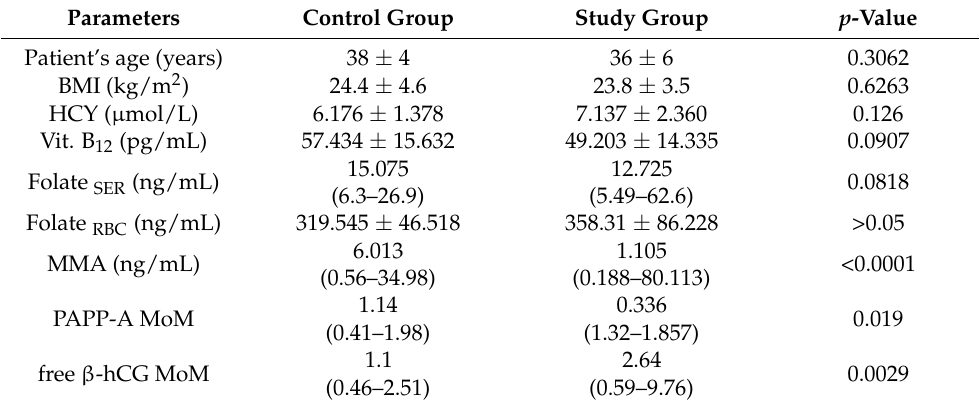
Table 2. Characteristics of the clinical and biochemical parameters in the control and study groups.